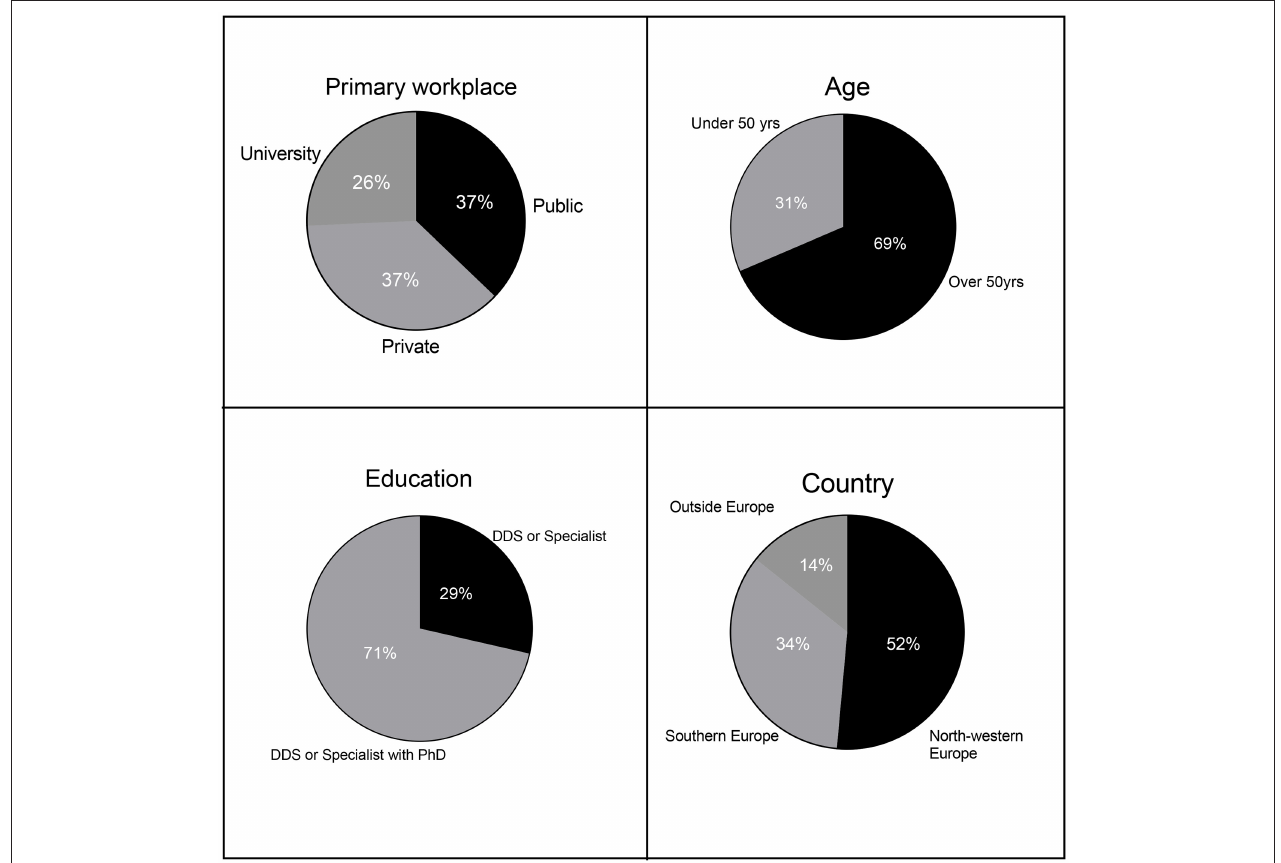
FIGURE 2 | Demography table.